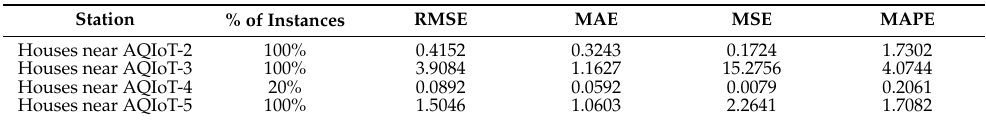
Table 7. Error metrics results of the LSTM neural network model during testing and validation stages (indoor